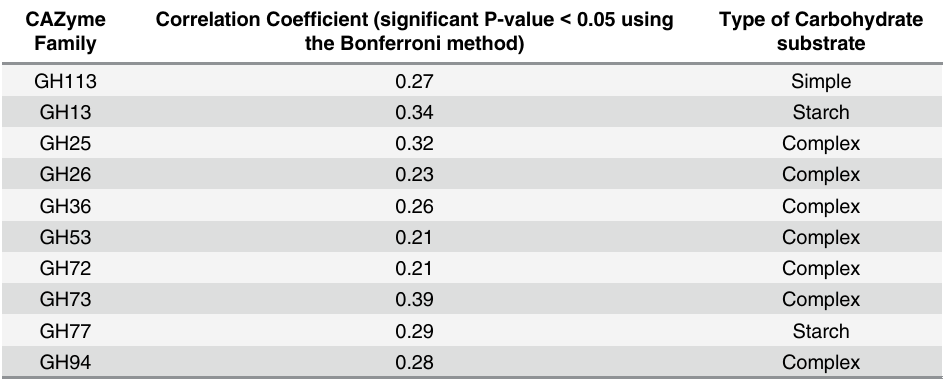
Table 1. List of CAZyme families having positive correlation with BMI along with their broad carbohy- drate substrate classifications. CAZyme